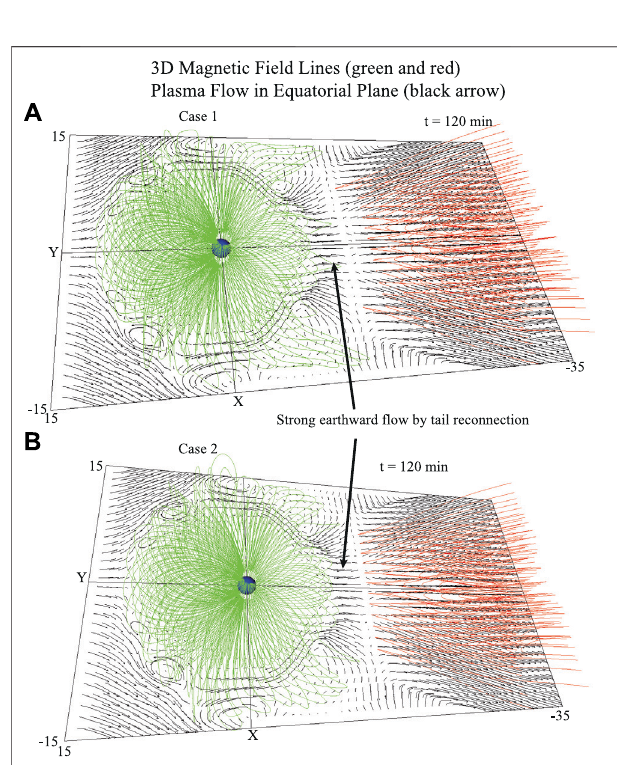
FIGURE 4 | 3D closed magnetic fi eld lines that indicate green and tail reconnection fi eld lines itindicatered at t (cid:1) 120 mininCase1 (A) and inCase2 (B) . The black arrow indicate equatorial magnetospheric